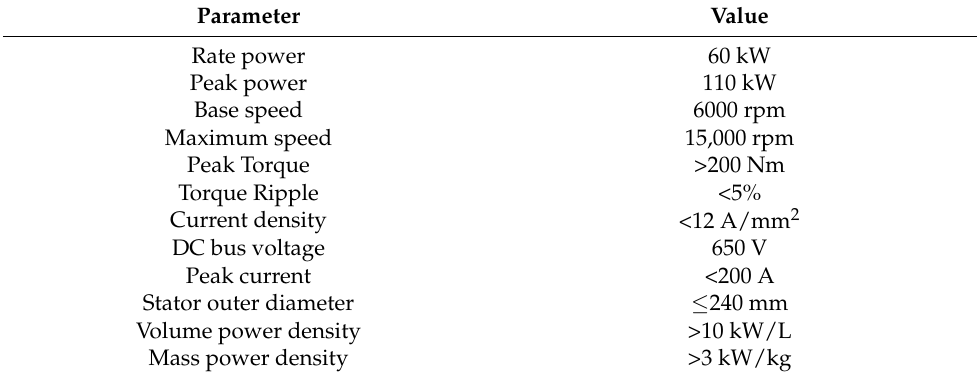
Table 3. Main indicators of HPDM.